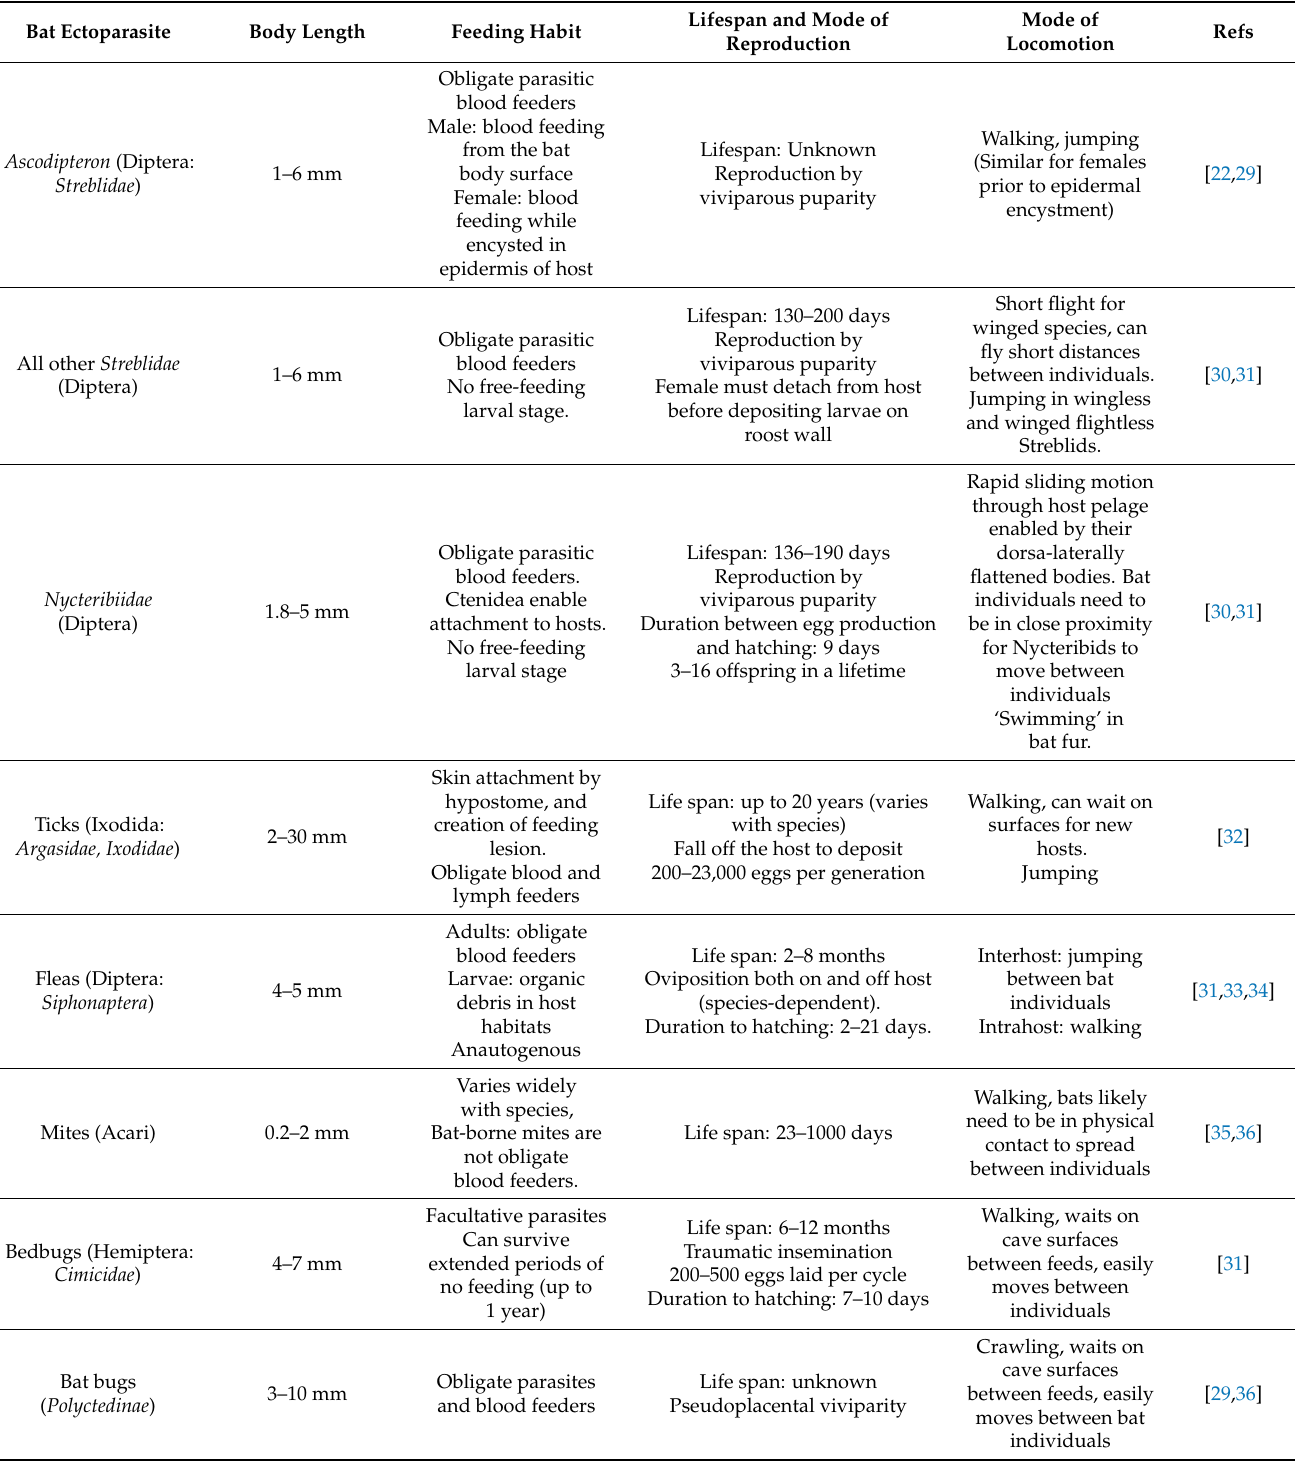
Table 1. Bat ectoparasite